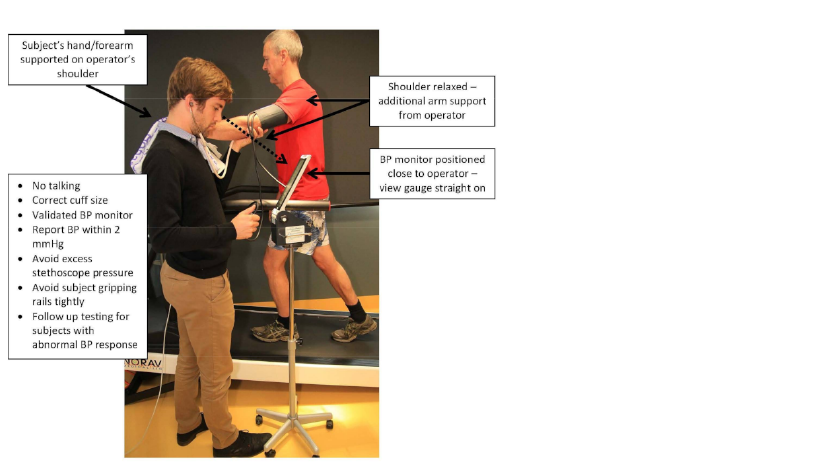
Figure 2. Appropriate blood pressure (BP) measurement by manual auscultation during exercise stress testing from Sharman et al. [24], reproduced with permission from Springer